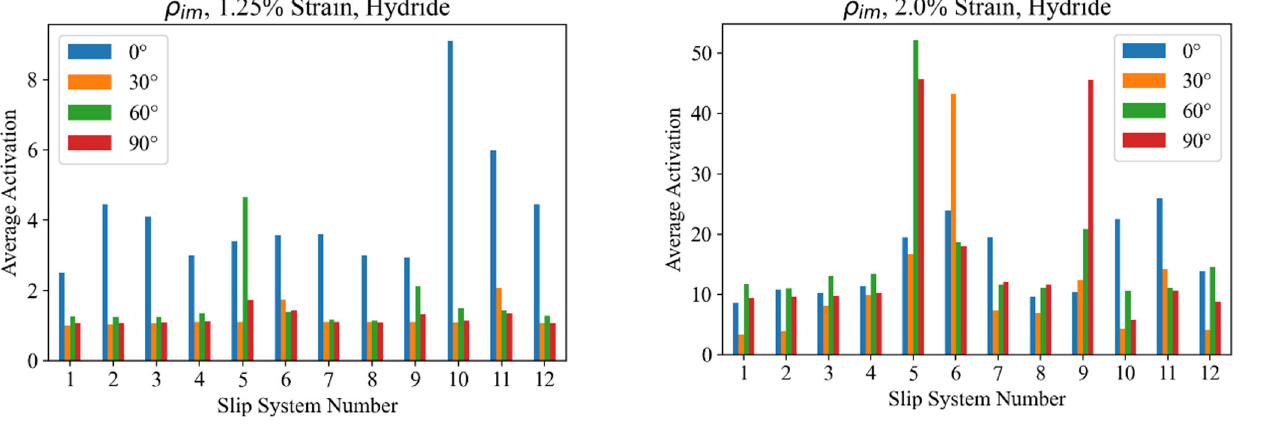
Fig. 23 Average immobile slip system activation for hydride material (fcc) at 1.25% nominal